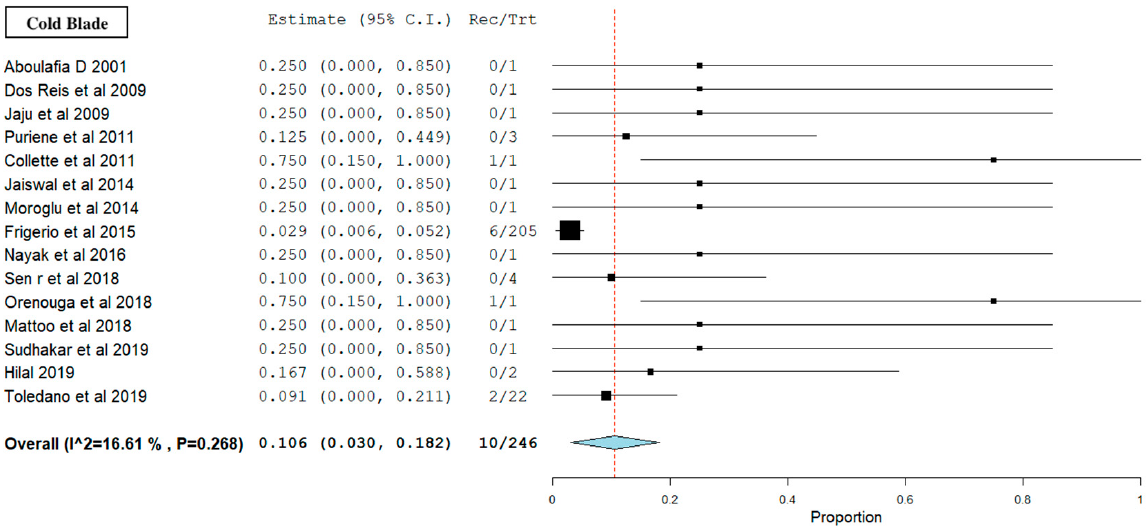
Figure 4. Forest-plot, cold-blade excision studies.